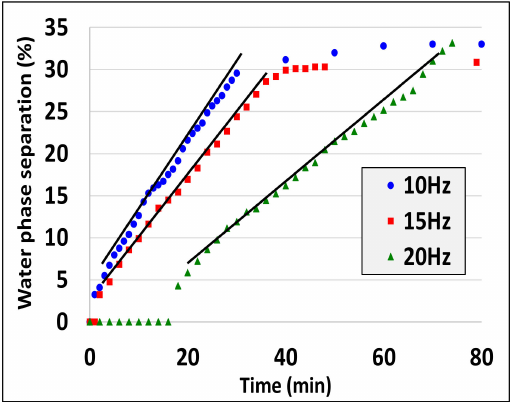
Figure 16. Phase separation front velocity calculation through line fitting.